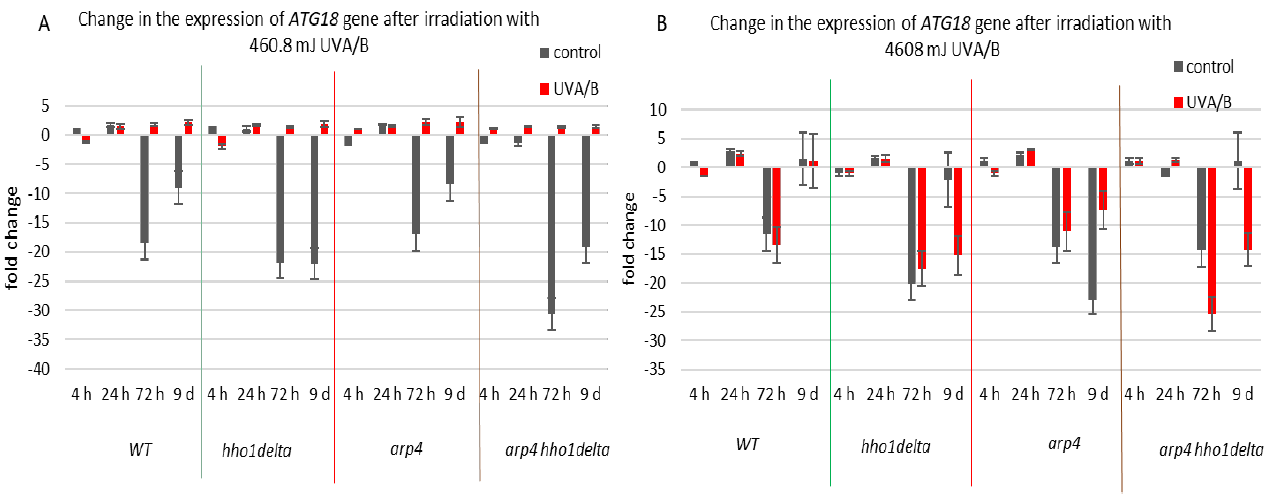
Figure 8. Change in the expression of ATG18 gene after UVA/B irradiation. ( A ) 3 min (460.8 mJ). ( B ) 30 min (4608 mJ). Three repetitions of the experiment are done and results are MEAN fold change ± STDV.